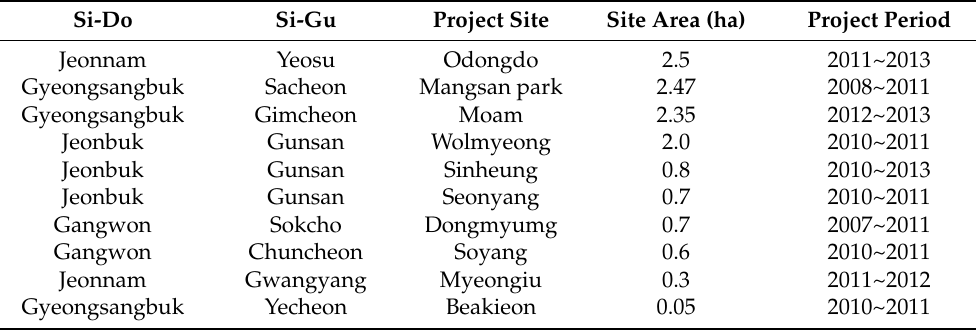
Figure 1. Location map of analysis areas. Source: Natural Disaster Management Institute. Korea, 2011 (http://www.ndmi.go.kr/research/research/view.jsp). Table 4. Project sites for benefit/cost analysis (NEMA, 2012).